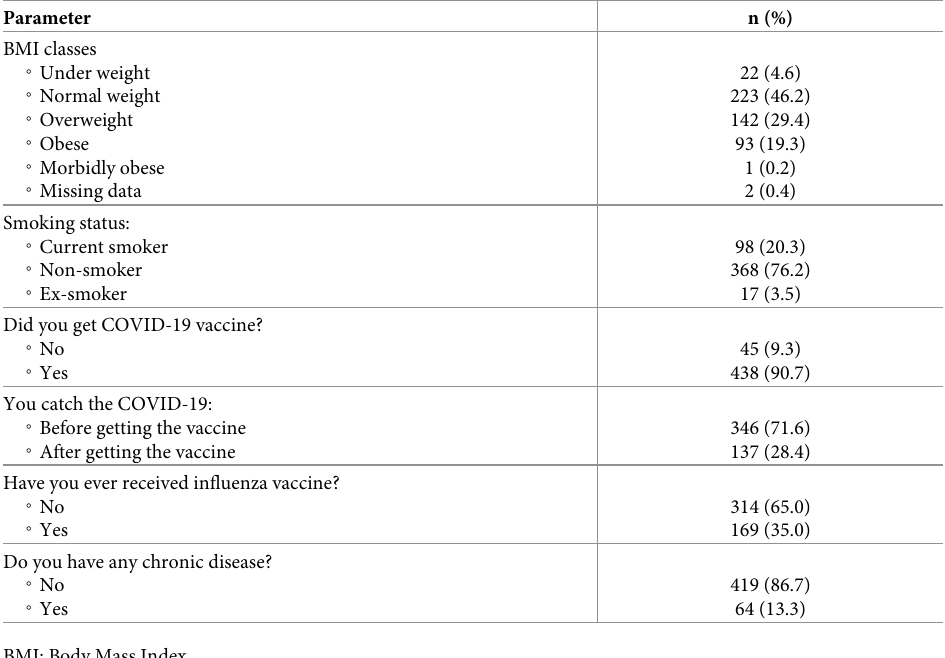
Table 2. Medical information of the study sample (n =